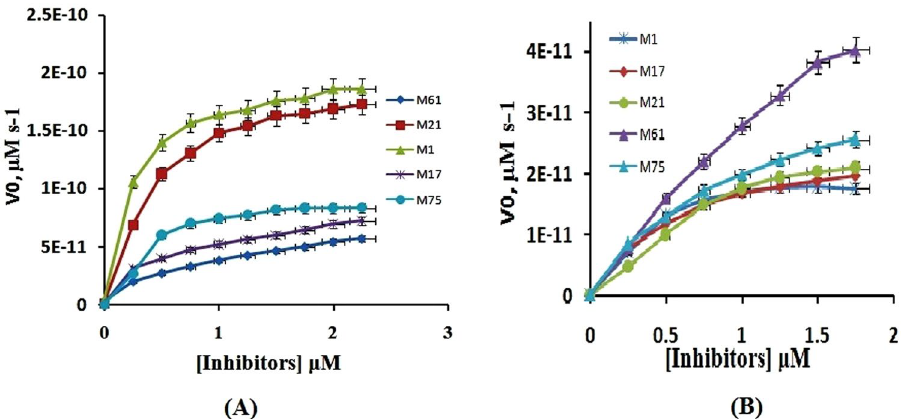
Figure 4. Determination of different types of inhibitor and different antibiotics for the NDM-1, represented the best fit (non linear regression). Panel 4 A shows inhibitor M1, M17, M21, M61 and M75 with antibiotics